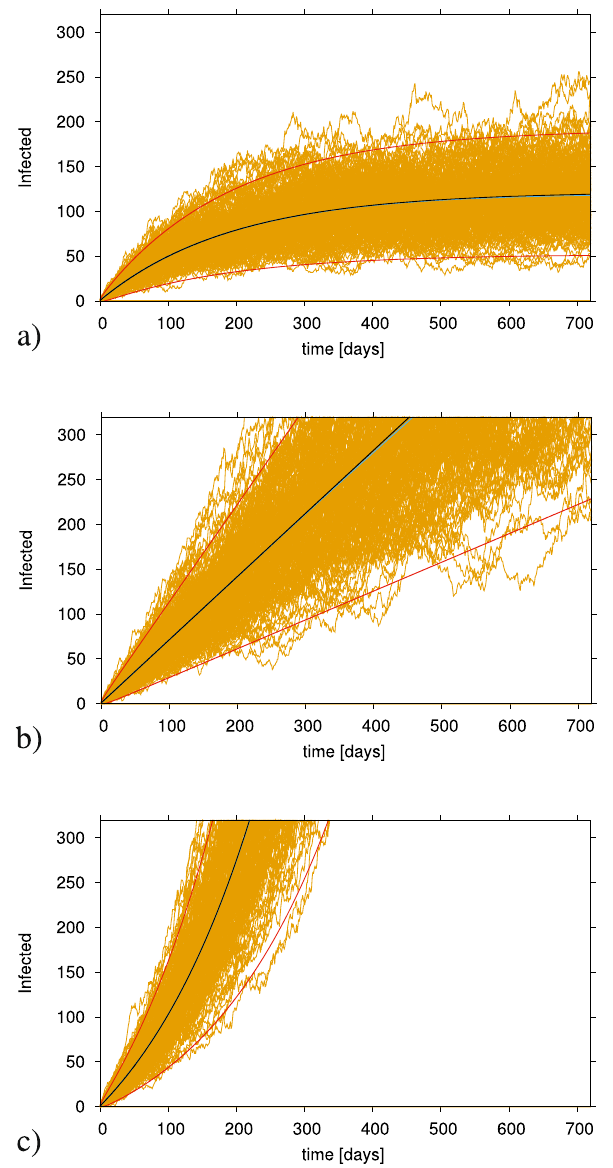
solution. With N = 2 · 10 6 , γ = 0.05 d − 1 and import ̺ = e − 12 , infection rate β varies from sub - to super- critical regimes. In ( a ) β = 0.9 · γ , in ( b ) β = β c = γ and in c) β = 1.1 · γ